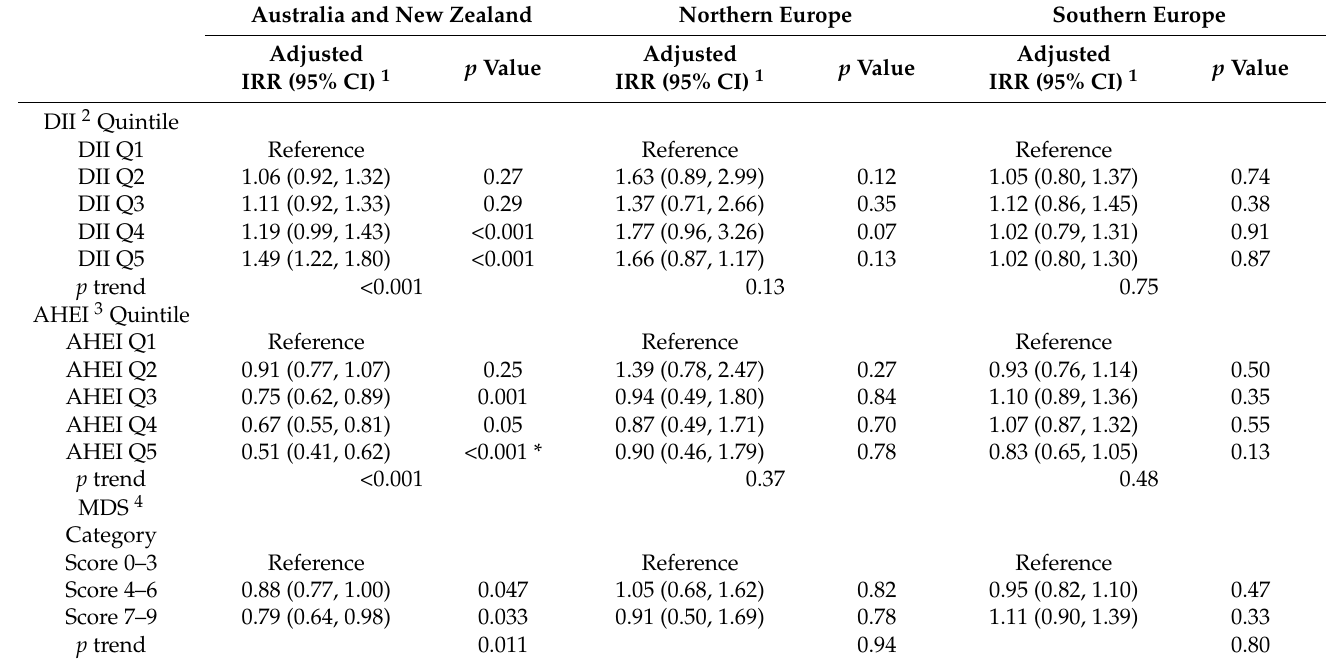
Table 4. Association of baseline dietary indices with diabetes adjusting for confounders stratified by region of birth. Australia and New Zealand Northern Europe Southern